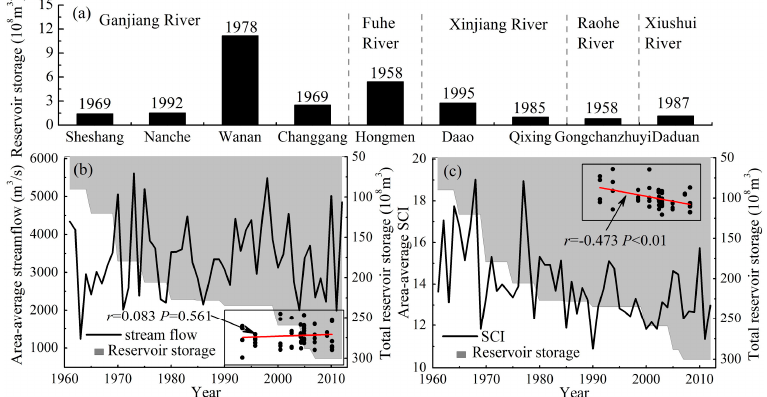
Figure 10. Large ‐ and medium ‐ sized reservoirs built during 1961–2012 in the five tributaries of the Poyang Lake Basin ( a ); total reservoir storage and area ‐ average stream flow series ( b ); and total reservoir storage and area ‐ average SCI series ( c ) in the Poyang Lake Basin from 1961 to 2012.